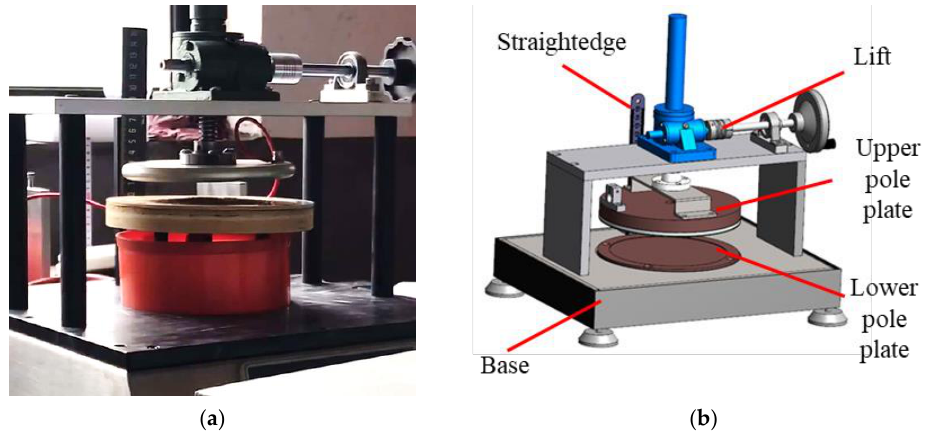
Figure 13. Electrostatic abrasive planting measuring equipment. ( a ) Experiment device; ( b ) structure diagram.